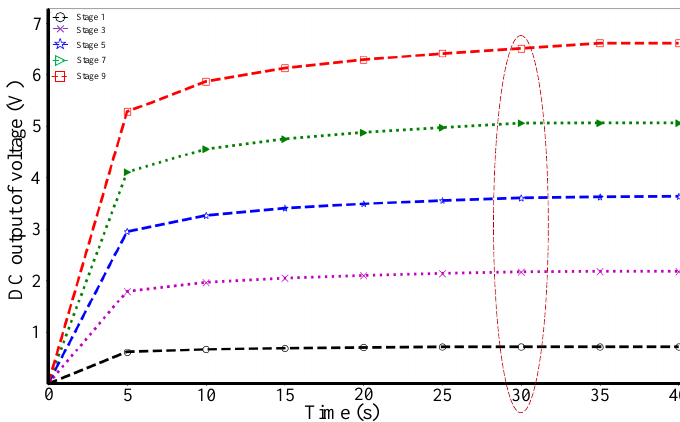
Figure 6. Output values of voltage multiplier with different stages.